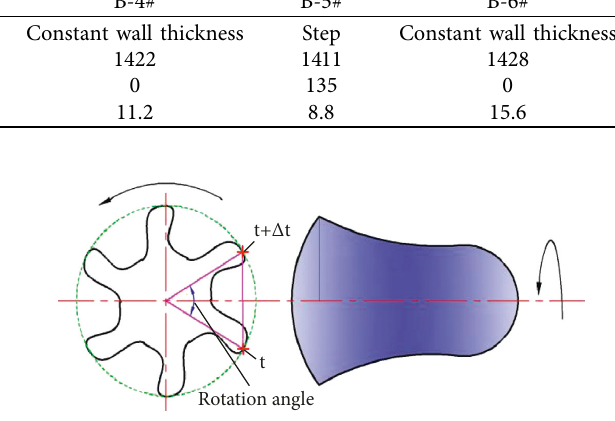
Figure 10: Schematic diagram for the measurement of the EFP angular velocity.